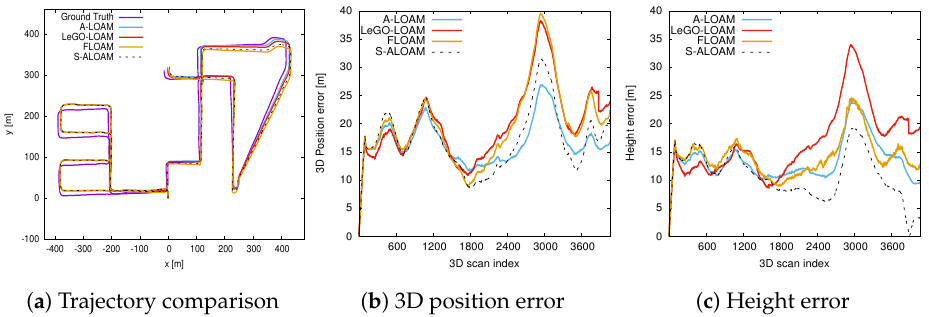
Figure 9. The trajectory comparison in Sequence 08. ( a ) The plot of the trajectories from different methods. ( b ) The absolute 3D translation error. ( c ) The absolute height